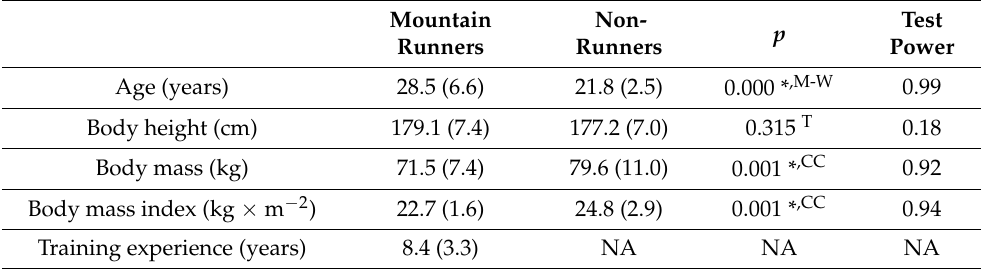
Table 1. Basic characteristics (mean (SD)) of the studied populations.